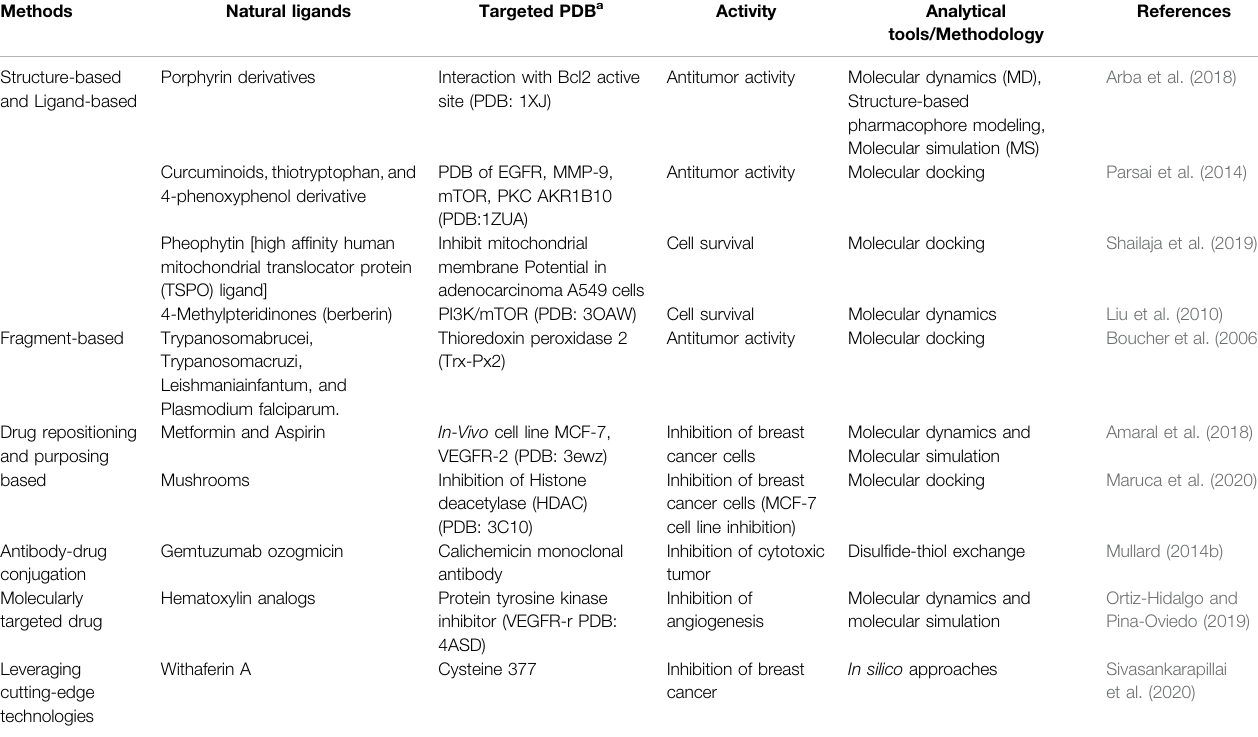
TABLE 2 | Novel natural anticancer drug development